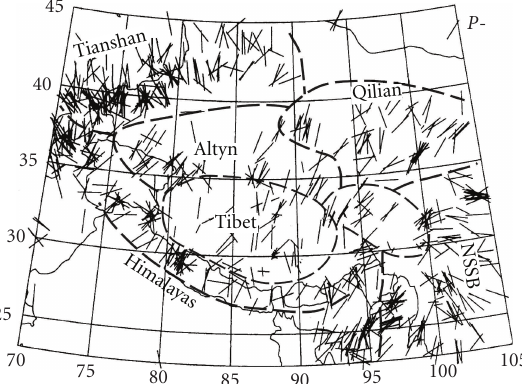
Figure 4: Distribution of extensional axes (T-) in and around the Tibetan